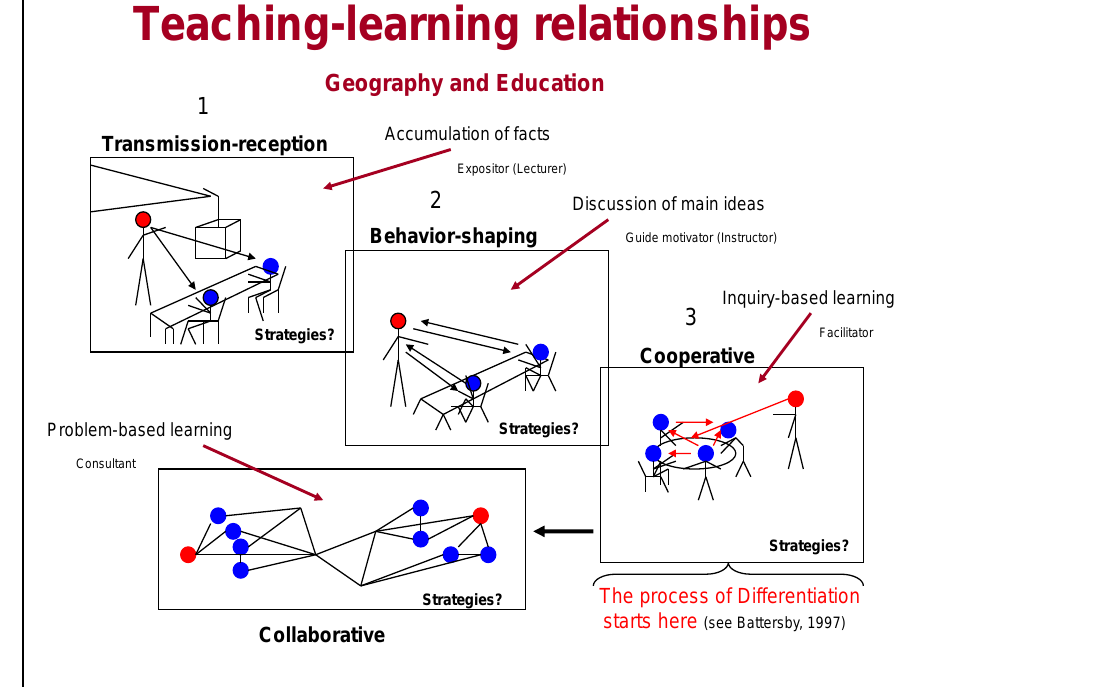
Figure 2 . Case 3 as the most common typical environment of the